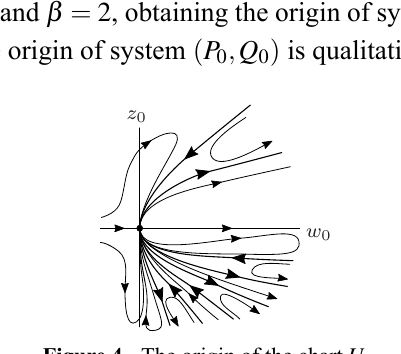
Figure 4 - The origin of the chart U 1